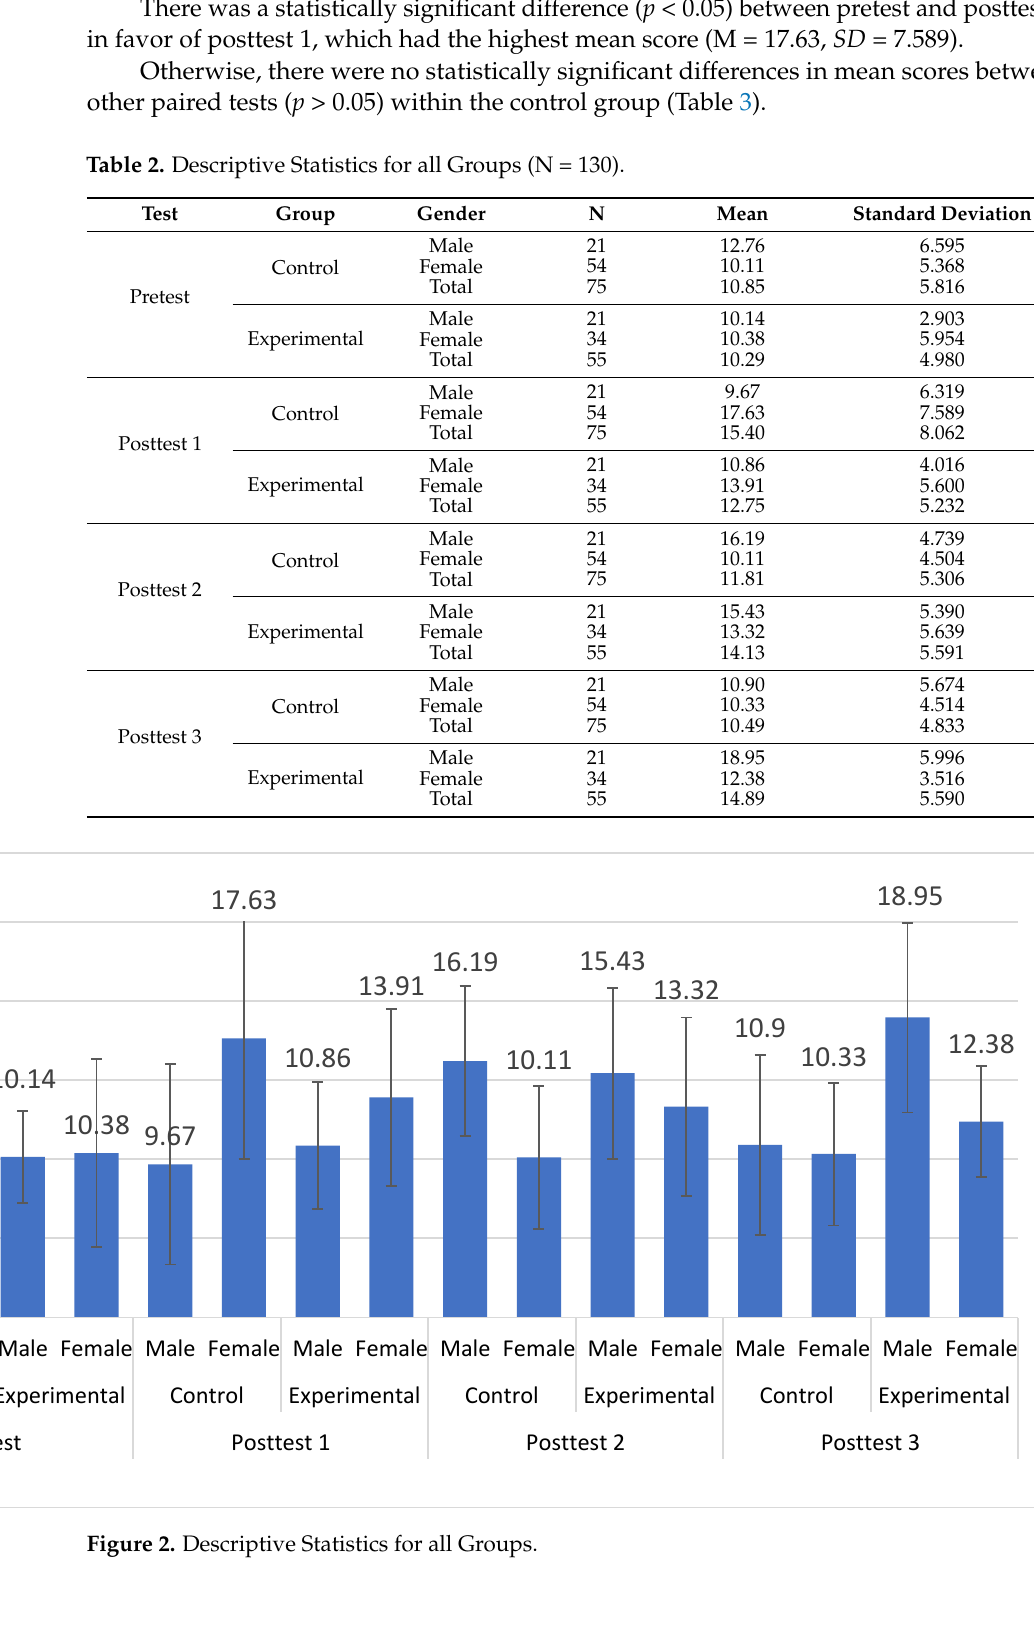
Table 2. Descriptive Statistics for all Groups (N = 130).